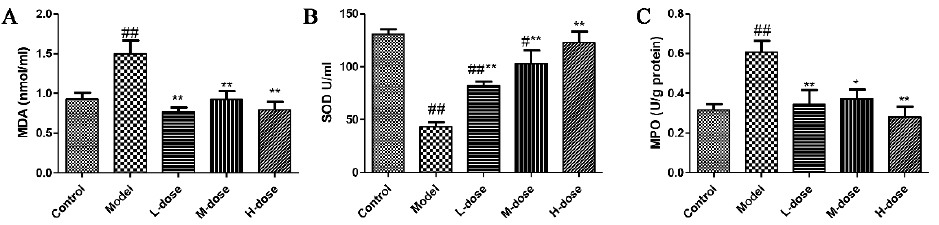
Figure 2. The effect of Forsythia suspensa extract on the levels of MDA, SOD and MPO in mice. ( A ) MDA level in serum. ( B ) SOD level in serum. ( C ) MPO activity in colon tissue. Data represent at least three independent experiments. The results are shown as the mean ± SEM. # p < 0.05, and ## p < 0.01 compared with the control group; * p < 0.05, and ** p < 0.01 compared with the model group; #** means # and **; ##** means ## and **.